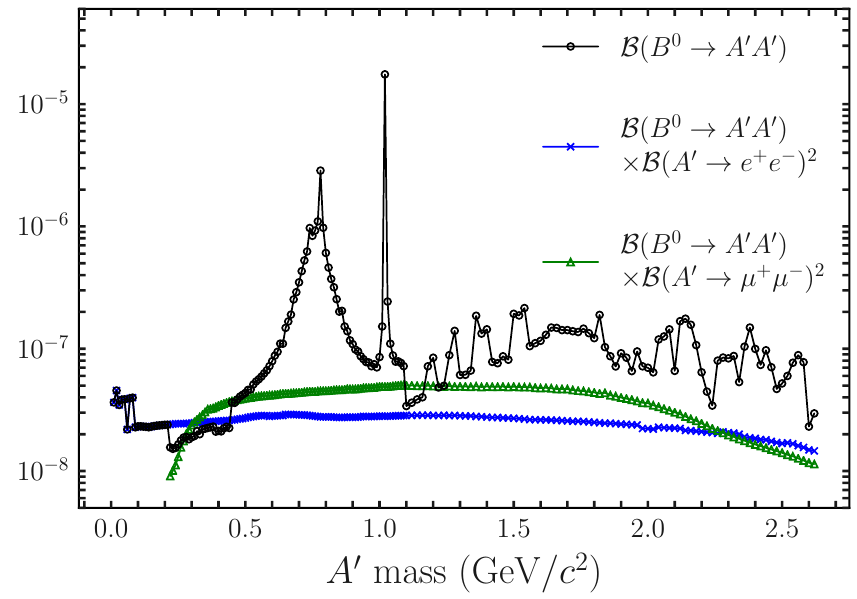
Figure 5 . Upper limits of B 0 → A 0 A 0 branching fraction at 90%